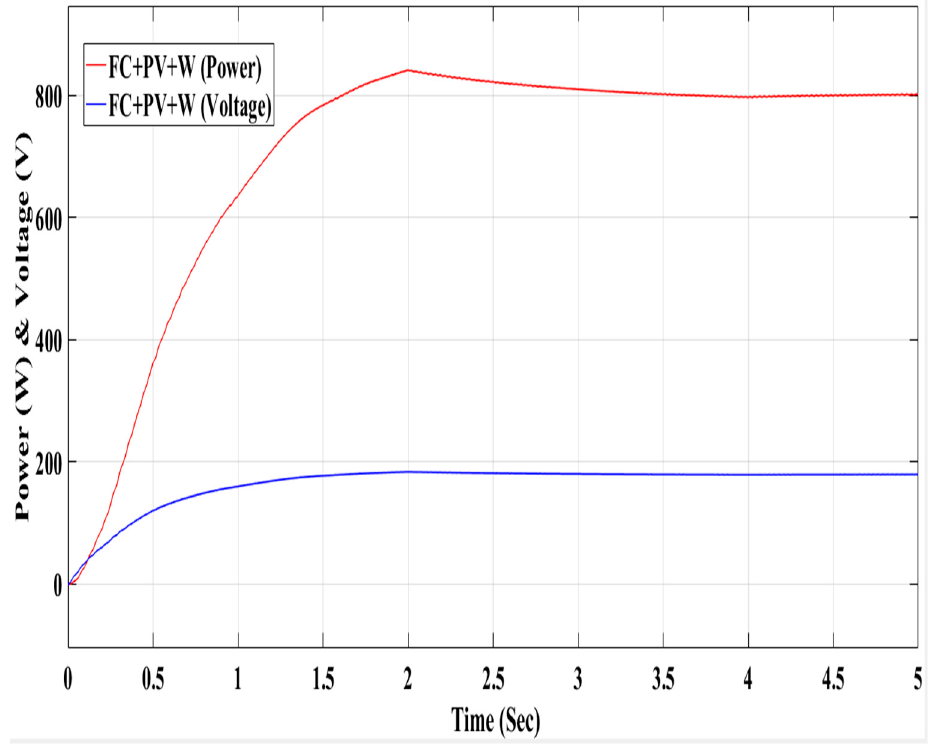
Figure 30. Power and voltage characteristics of the FC–PV–W model using a fuzzy logic controller.